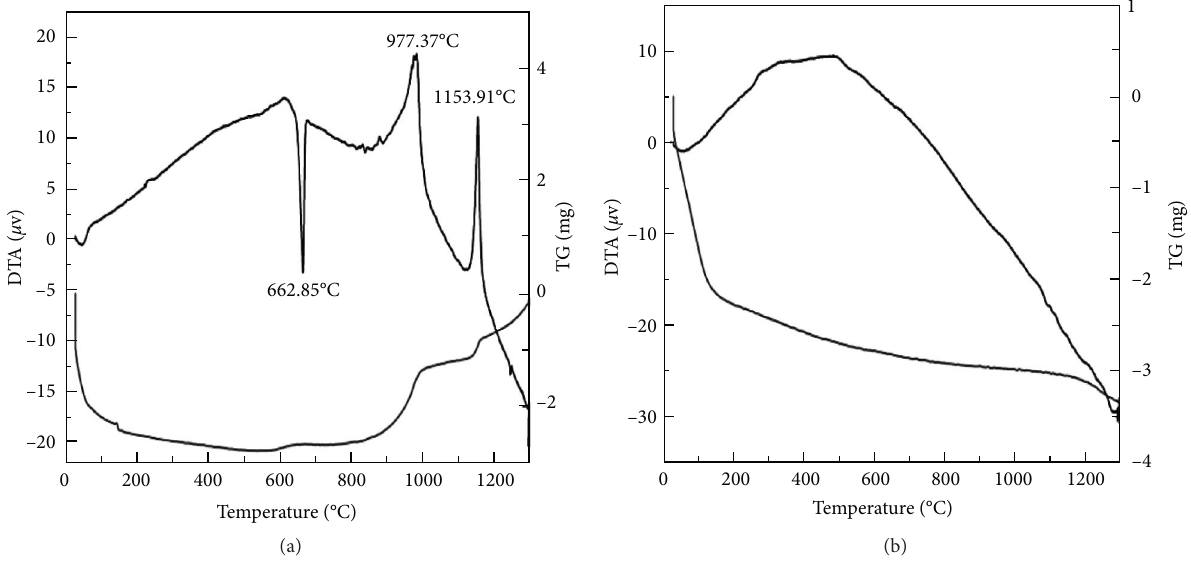
Figure 6: In the process of purification, the image should be considered separately according to the red, green, and blue color channels.